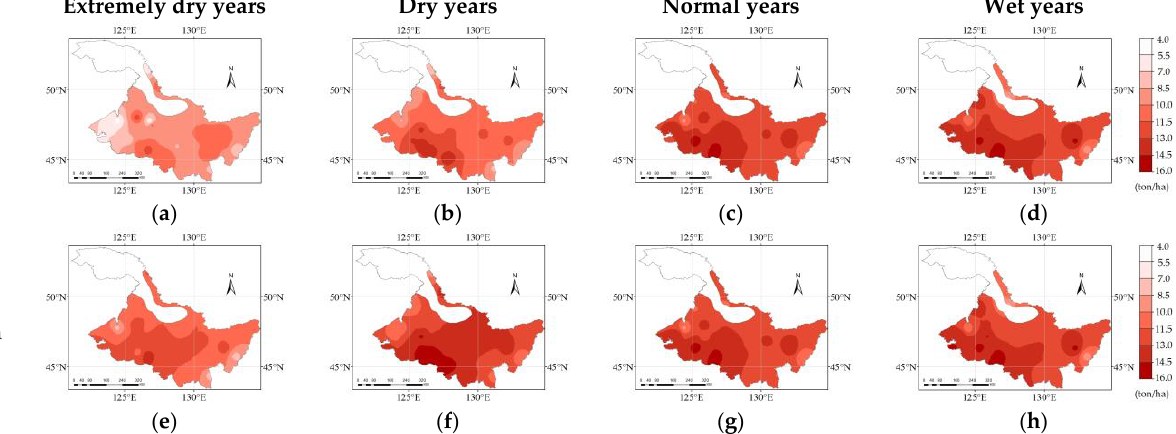
Figure 8. Spatial distribution of yield in extremely dry years ( a , e ), dry years ( b , f ), normal years ( c , g ), and wet years ( d , h ) under the rainfed and irrigation scenario .